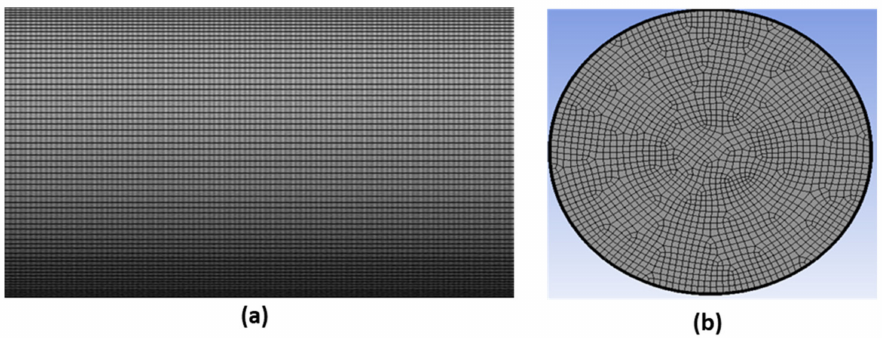
Figure 2. Hexahedral mesh. ( a ) Horizontal view, and ( b ) side view showing the